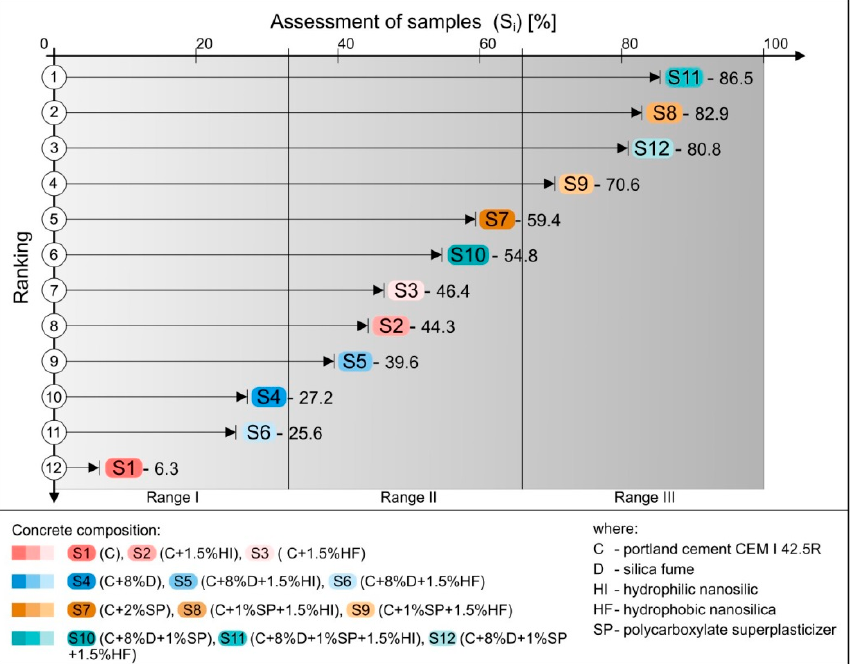
Figure 5. Ranking of concrete mixes tested based on the final score, taking into account physical and mechanical properties and economic and environmental aspects (suggested ranges of application are marked as Ranges I–III).